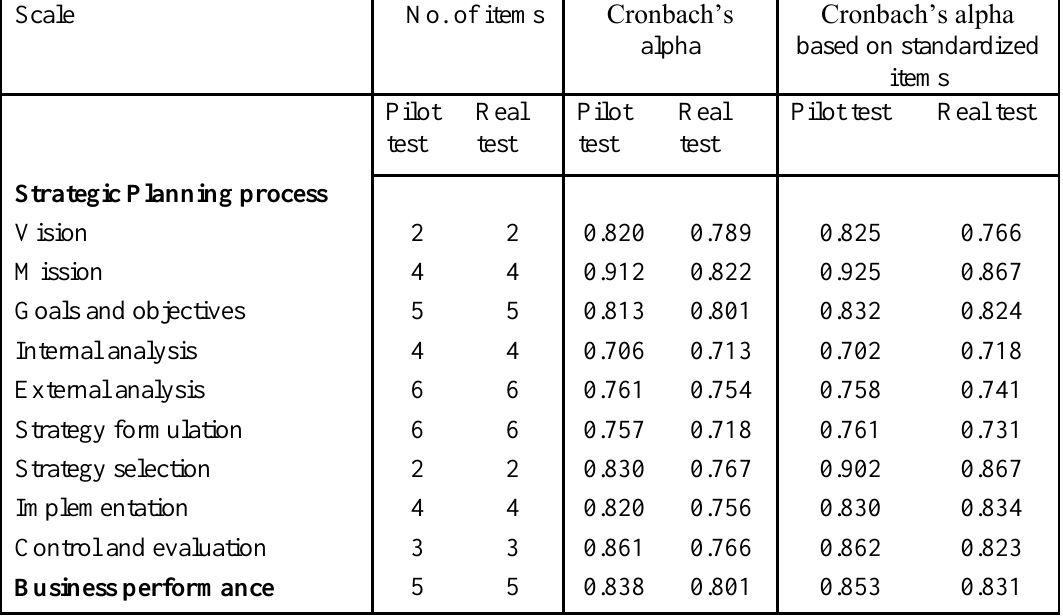
Table 5: Cronbach’s Alpha Statistics of Scales: Pilot Study and Main Study